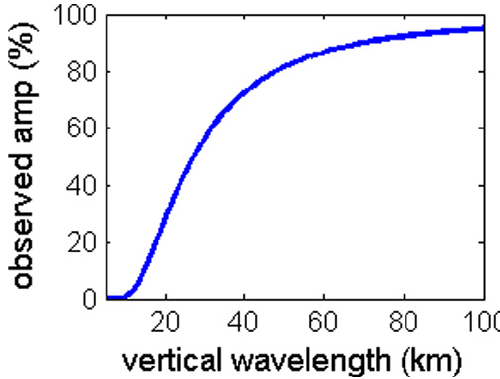
Fig. 8. Ratio of the observed to “true” amplitude of an atmospheric wave observed by the SuperDARN radar plotted as a function of the wave’s vertical